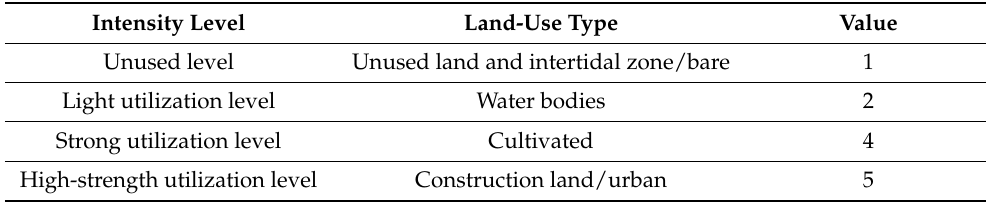
Table 2. Levels/categories of land-use